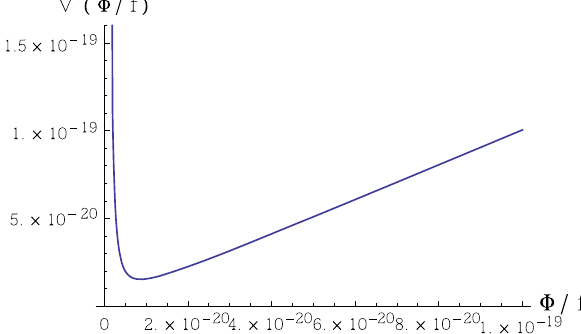
Fig. 4 First derivative of the modular potential for the ADS brane for ω = 10 −